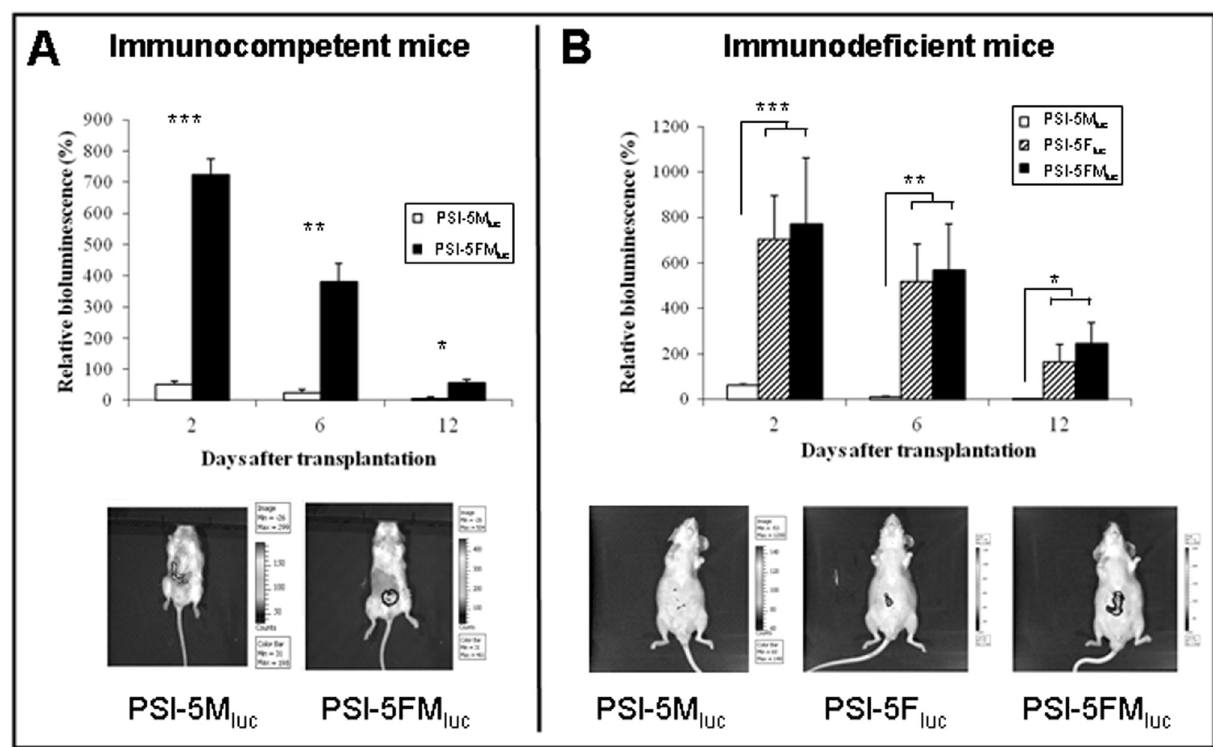
Figure 3. Evolution of bioluminescent cells embedded in PSI and subcutaneously transplanted in both immunocompetent and immunodeficient